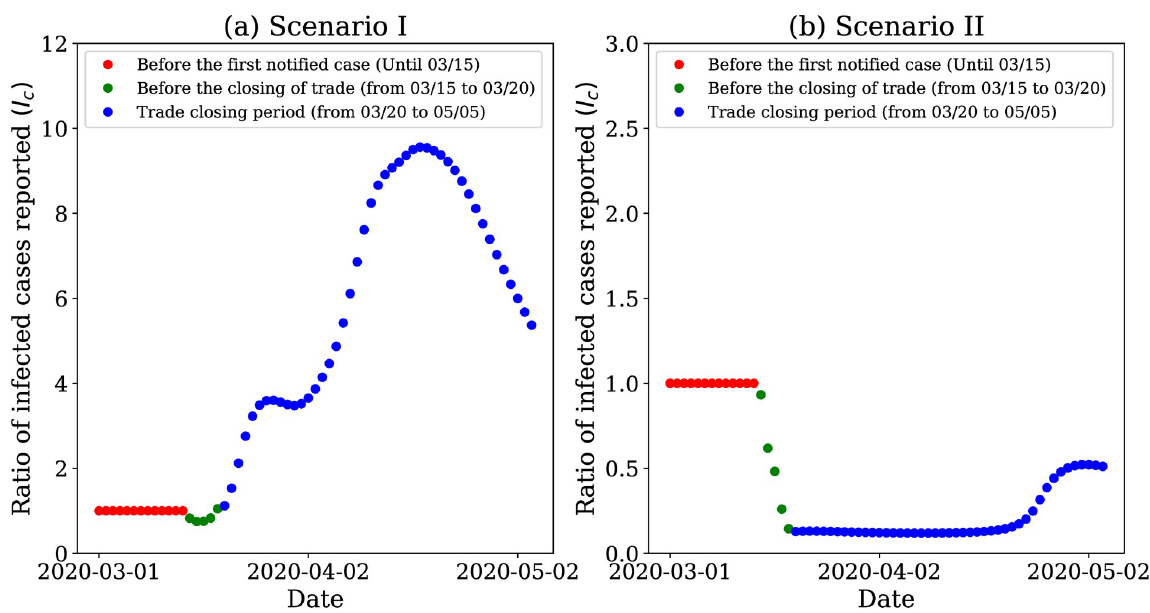
Fig 13. Results of hypothetical scenarios for fine-grained data. Model’s response when simulating hypothetical scenarios in Fortaleza when we apply fine-grain spatial mobility data.